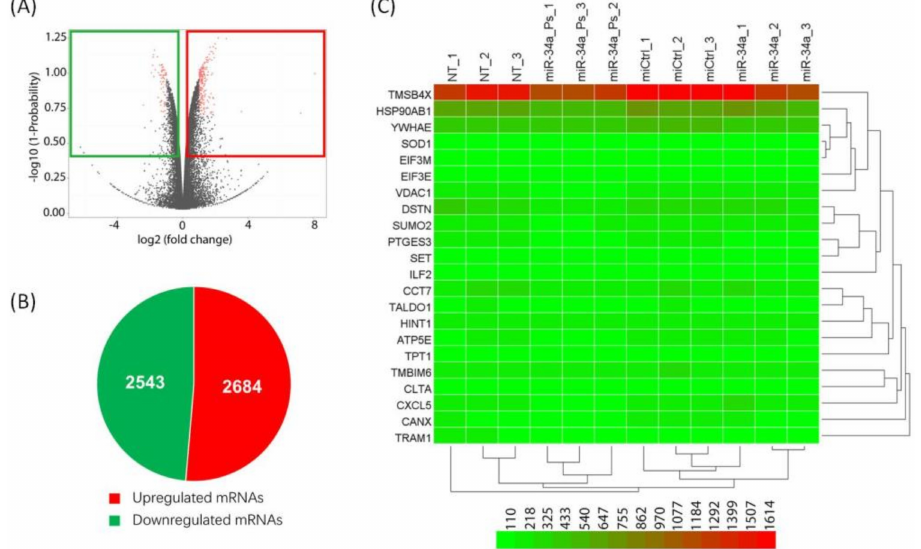
Figure 5. RNA-seq analysis of total RNA isolated from cells transfected with either control miR (miCtrl) or miR probe. ( A ) Volcano plots of mRNAs di ff erentially expressed between miCtrl vs miR-34a-ps (left) treated cells; ( B ) Pie charts showing the number of alternatively expressed genes in cells treated with either miCtrl or miR probe; and, ( C ) Di ff erentially expressed genes in miCtrl or miR probe treated cells are analyzed using hierarchical clustering. Each role represents a single mRNA and each column represents one RNA sample. The triplicate samples represent nontreated (NT_1, NT_2, NT_3), miR control (miCtrl1_, miCtrl_2, miCtrl_3), miR probe (miR-x_Ps_1, miR-x_Ps_2, miR-x_Ps_4), and miR (miR-x_1, miR-x_2, miR-x_3). x,